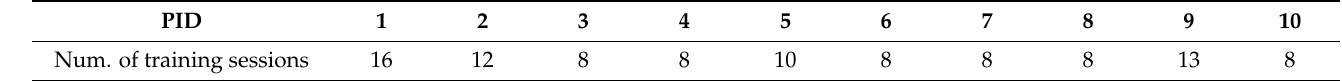
Table 2. Number of conducted training sessions per participant.